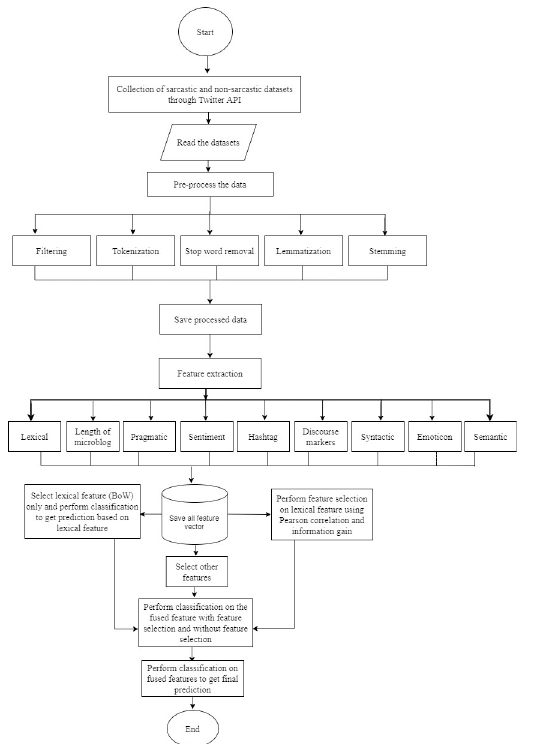
Fig 2. The flowchart of the proposed